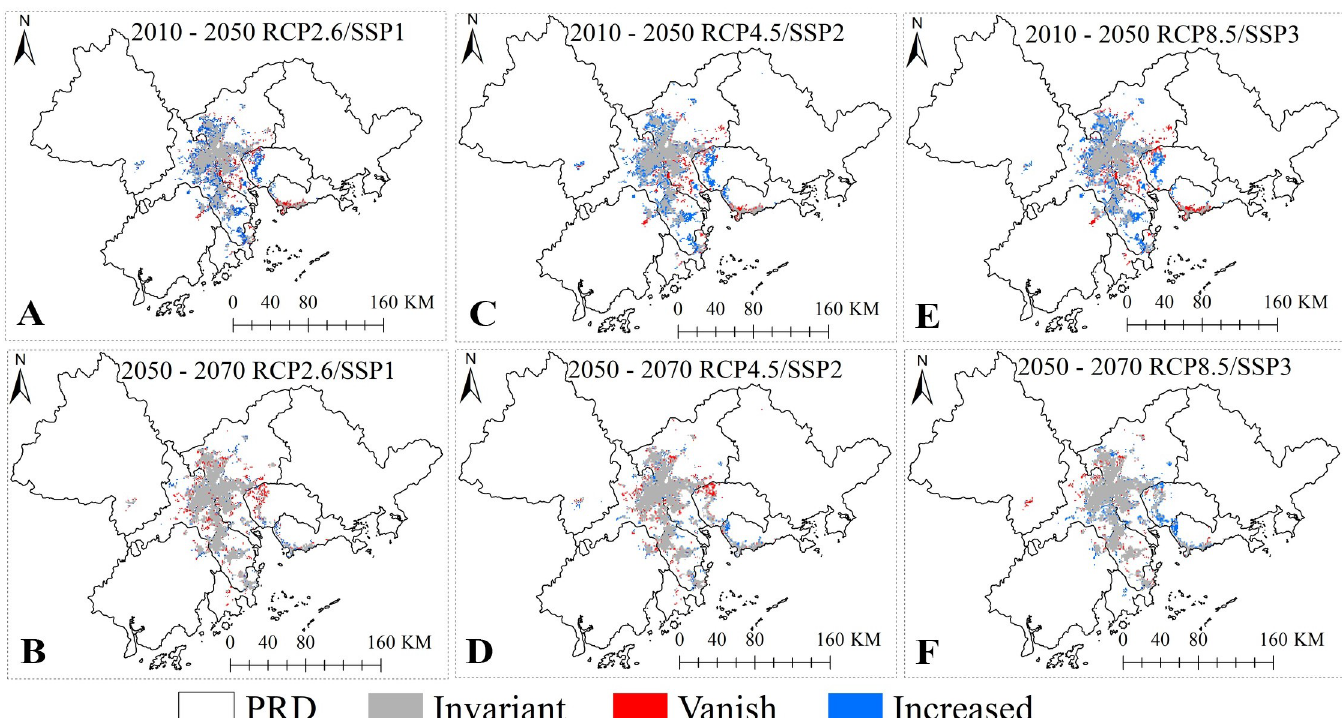
Fig 6. Spatial evolution of the DF high-risk areas under the different RCP/SSPs scenario in the C&S model. https://www.resdc.cn/data.aspx?DATAID=201.